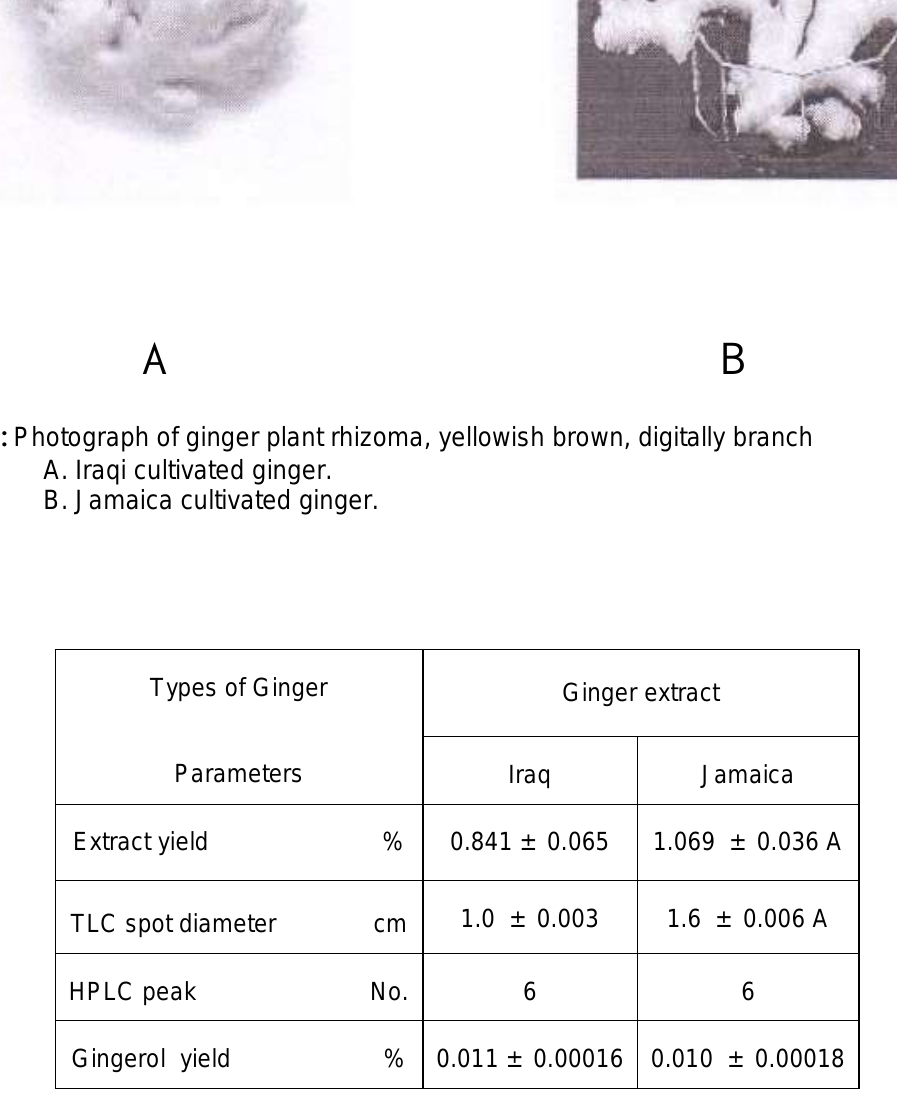
Table (1 ) Evaluation of ginger extract and Gingerol in different setting of analysis. Values are presented as mean ± SEM (n: seven batches) A: significant